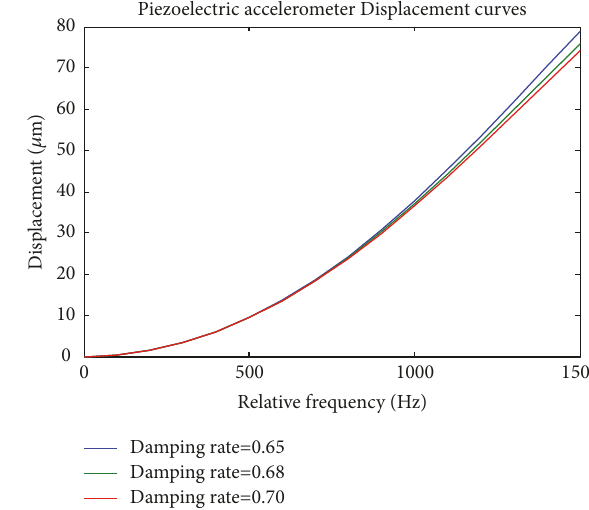
Figure 4: Displacement as a function of relative frequency for three values of damping rate in the resonance case.